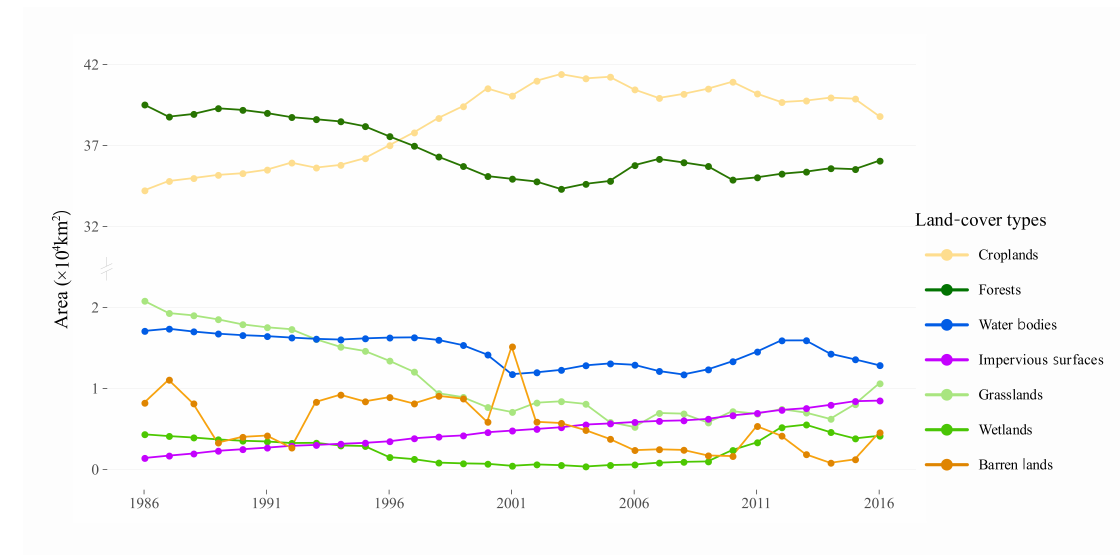
Figure 3. Area change in different land cover classes in Northeast China from 1986 to 2016. Since the area of croplands and forests is much larger than all other classes, we placed a scale break on the y -axis.